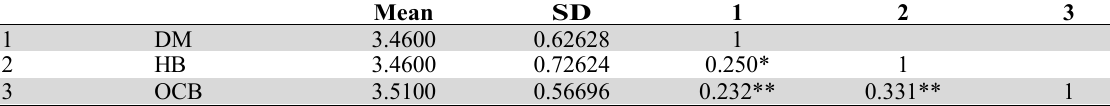
Means,Standard deviations and Correlation